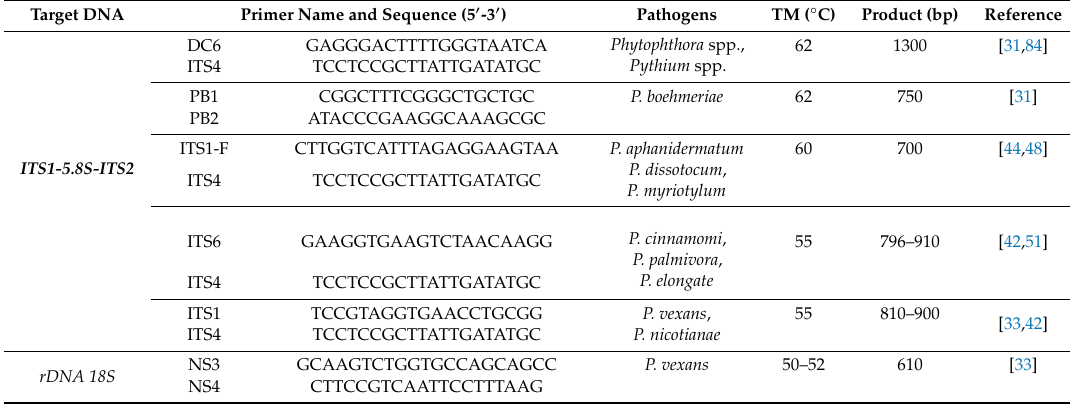
Table 3. Genes and PCR primers used for their amplification of oomycete infecting fiber crops. Target